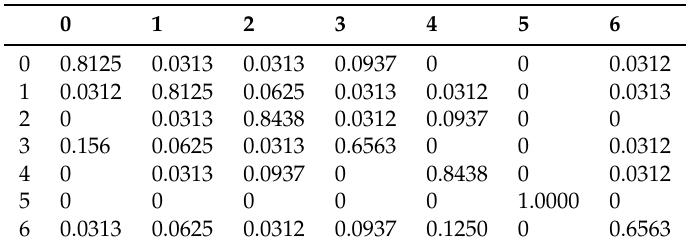
Table 8. Classification confusion matrix (ratio) for DataSet1 by using the PWGAN.